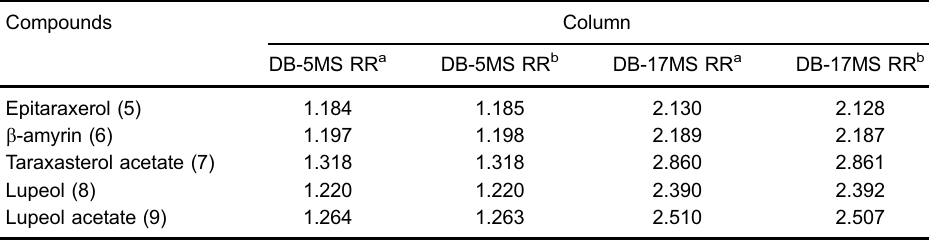
Table 1. Gas chromatograph-mass spectrometry analysis of the hexane fraction (HF) obtained from Gochnatia pulchra . Compounds